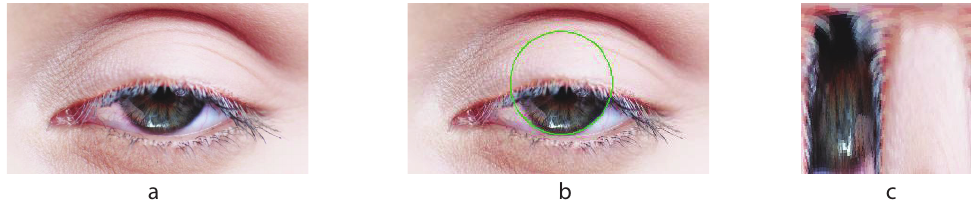
Figure 7. The proposed iris localization and normalization method: ( a ) original eye image, ( b ) iris localization, ( c ) iris